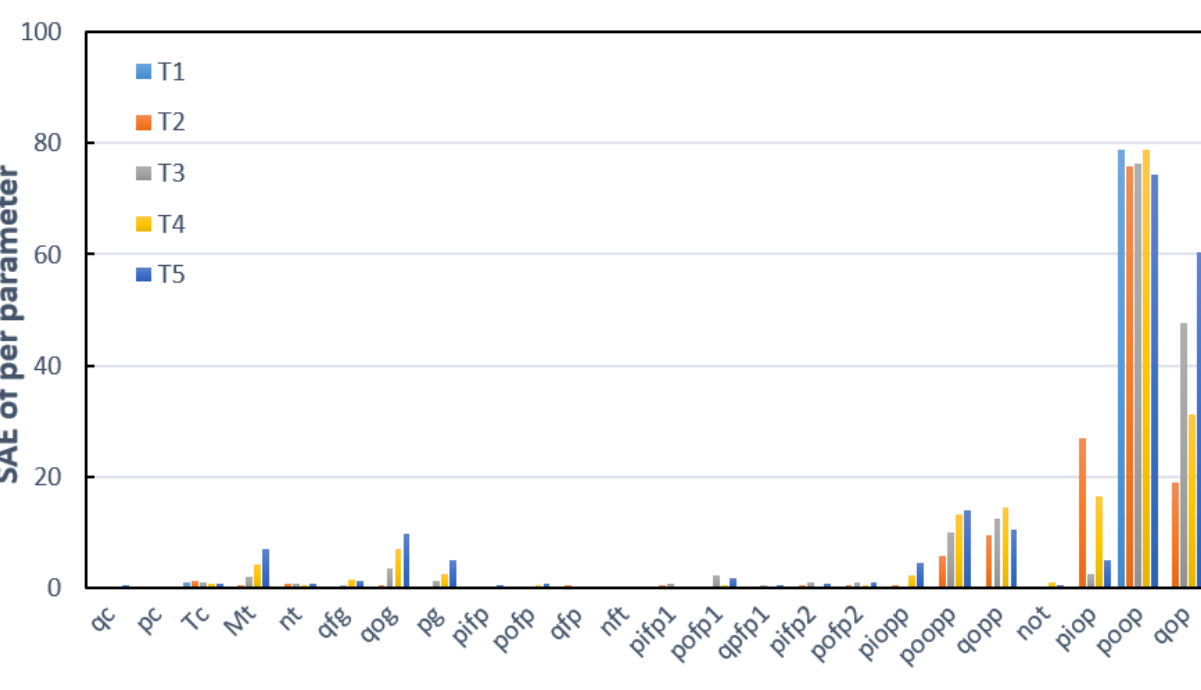
Figure 10. SAE of five consecutive samples after injection fault of test 13.